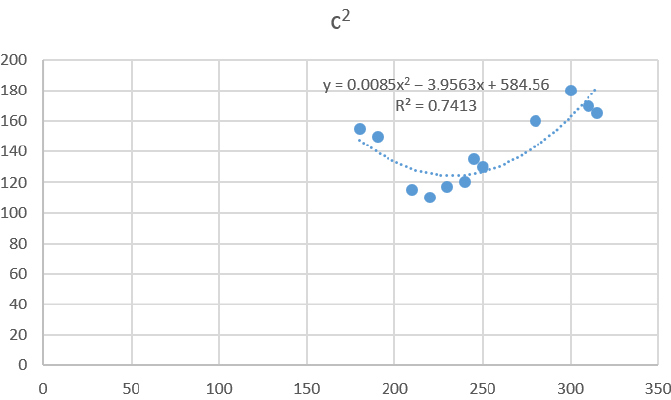
Figure 2. Analytical cost dependency on the size of the stock of the second type.